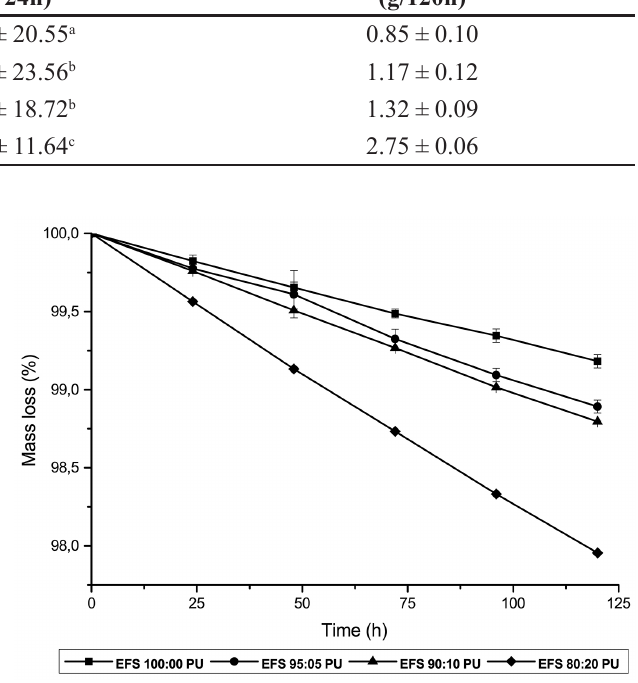
FIGURE 1 – Mass loss for films prepared at different EFS:PU ratios (n=3).